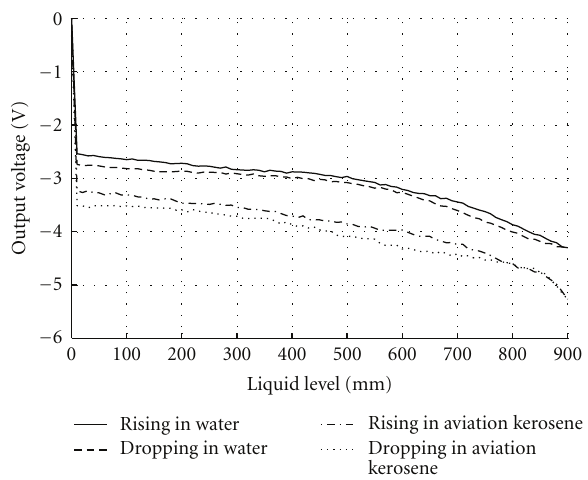
Figure 12: Output voltage versus liquid